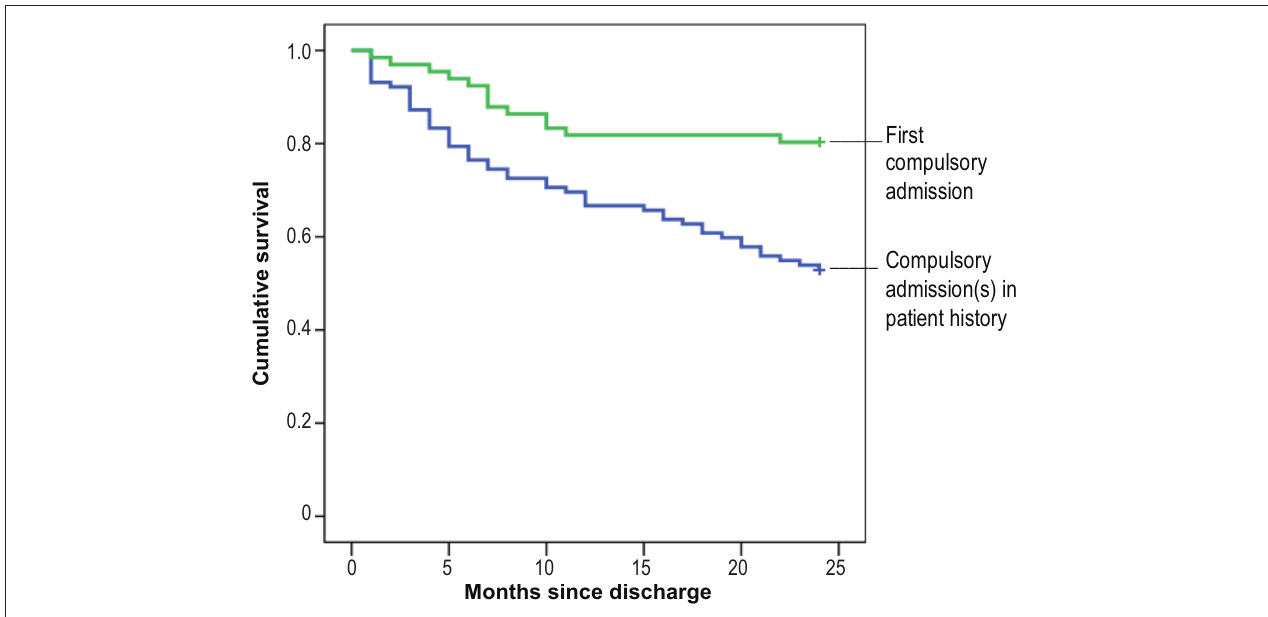
FIGURE 1 | Cumulative risk of compulsory re-admission among patients with vs. those without compulsory admission(s) in their patient history.